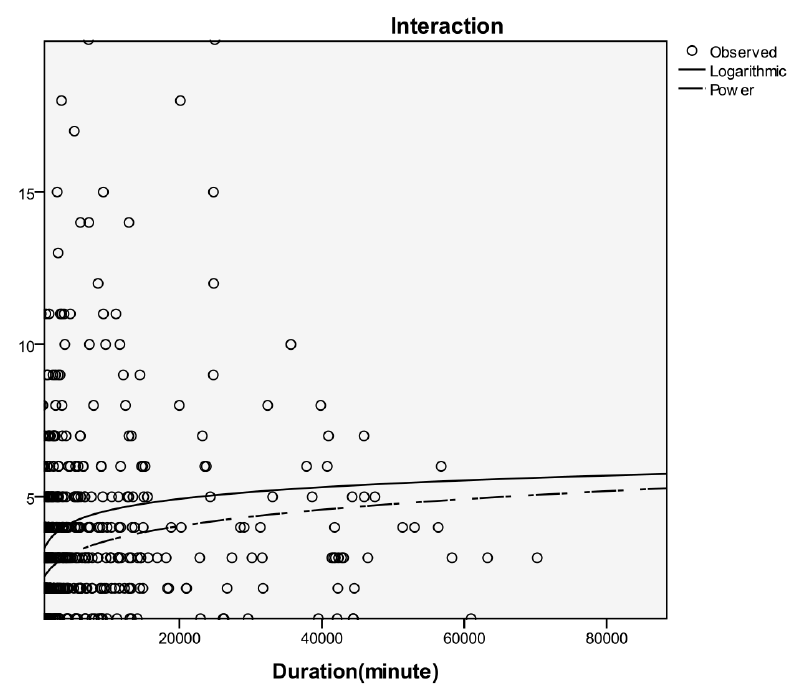
Figure 2. Fitted curve of interaction and duration